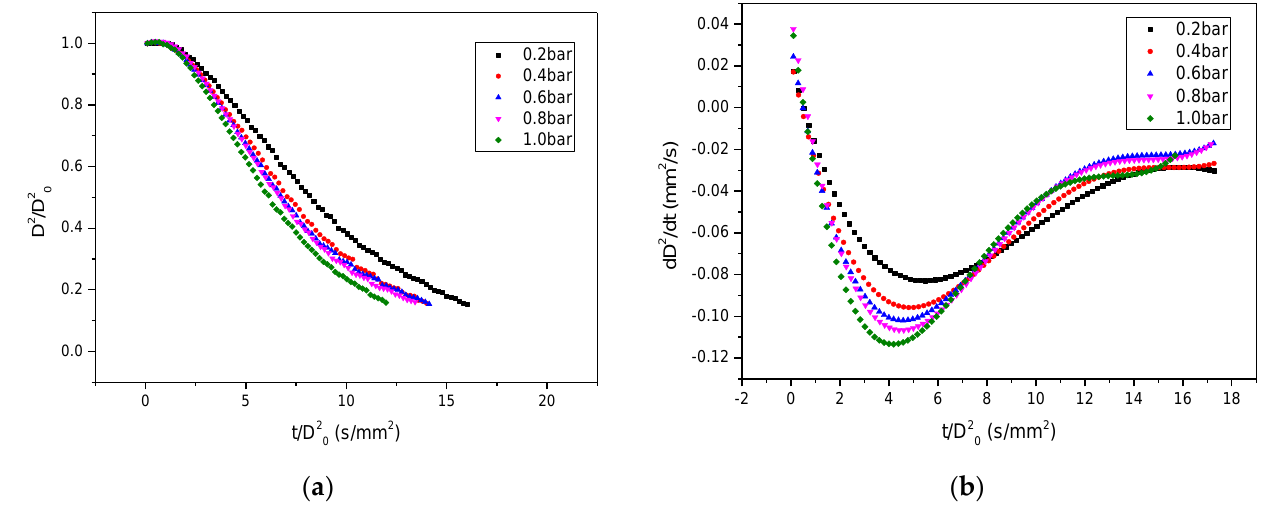
Figure 5. Influence of pressure on ( a ) temporal variation and ( b ) instantaneous rate of change of the normalized D 2 at 473 K.